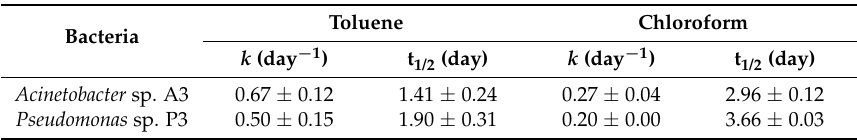
Table 5. Degradation rate constant ( k ) and half-life (t 1/2 ) for degradation of toluene and chloroform by Acinetobacter sp. A3 and Pseudomonas sp. P3.